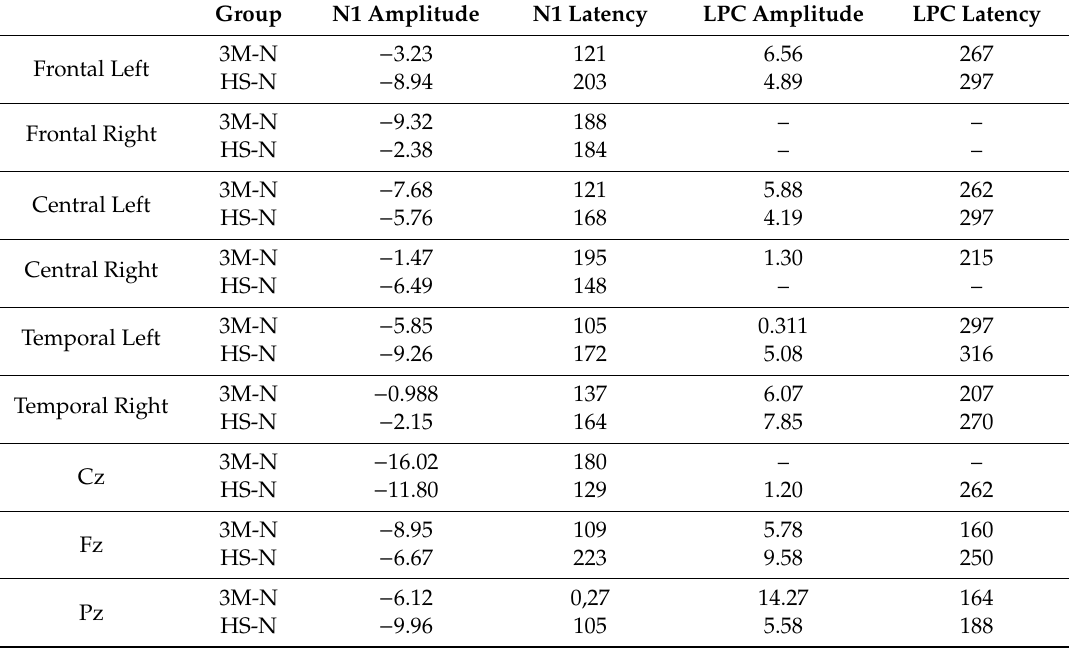
Table 2. Results of the descriptive analysis of the averaged amplitude ( µ V) and latency (ms) for N1 and LPC in 3M-N and HS-N. Two dashed lines indicate a lack of